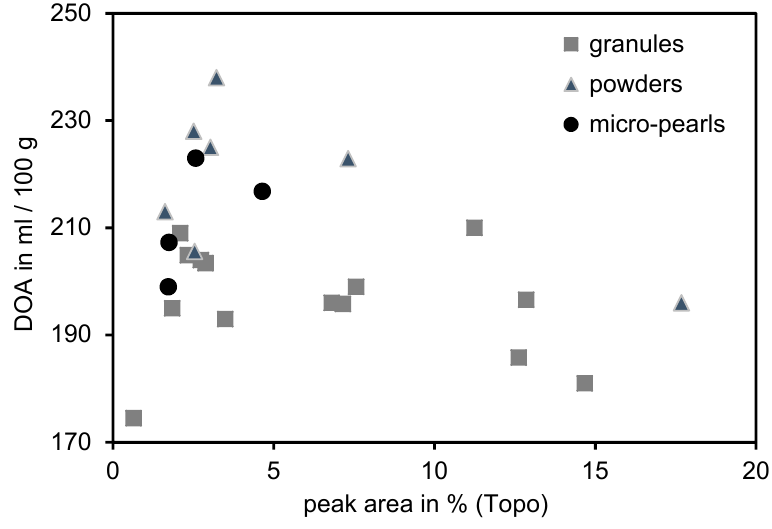
Figure 3. Correlation between the DOA measurement and the peak area obtained by means of the topography test .